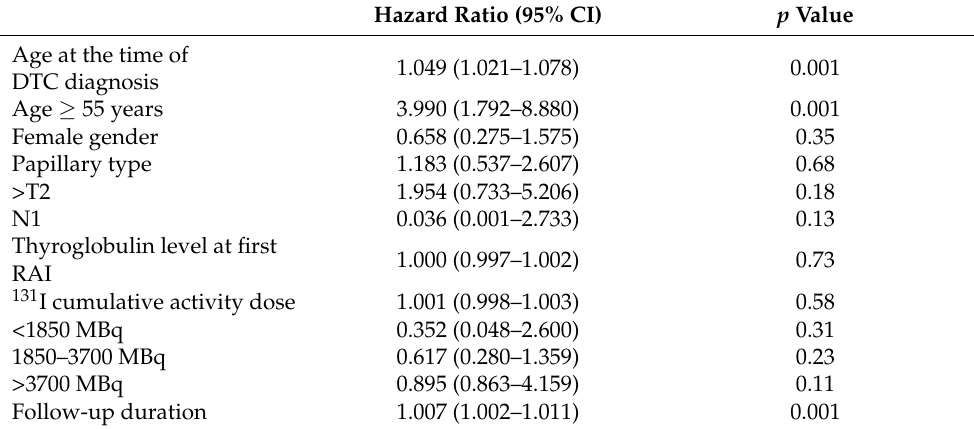
Table 3. Univariable predictors of